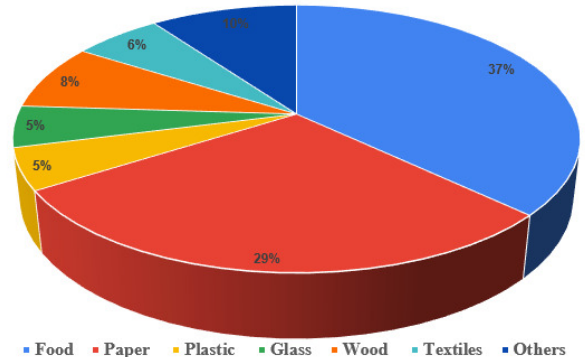
Figure 4. Composition of the Municipal Solid Waste (MSW) in KSA.